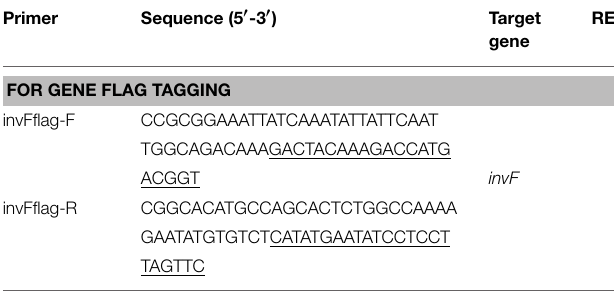
TABLE 2 | Primers used in this